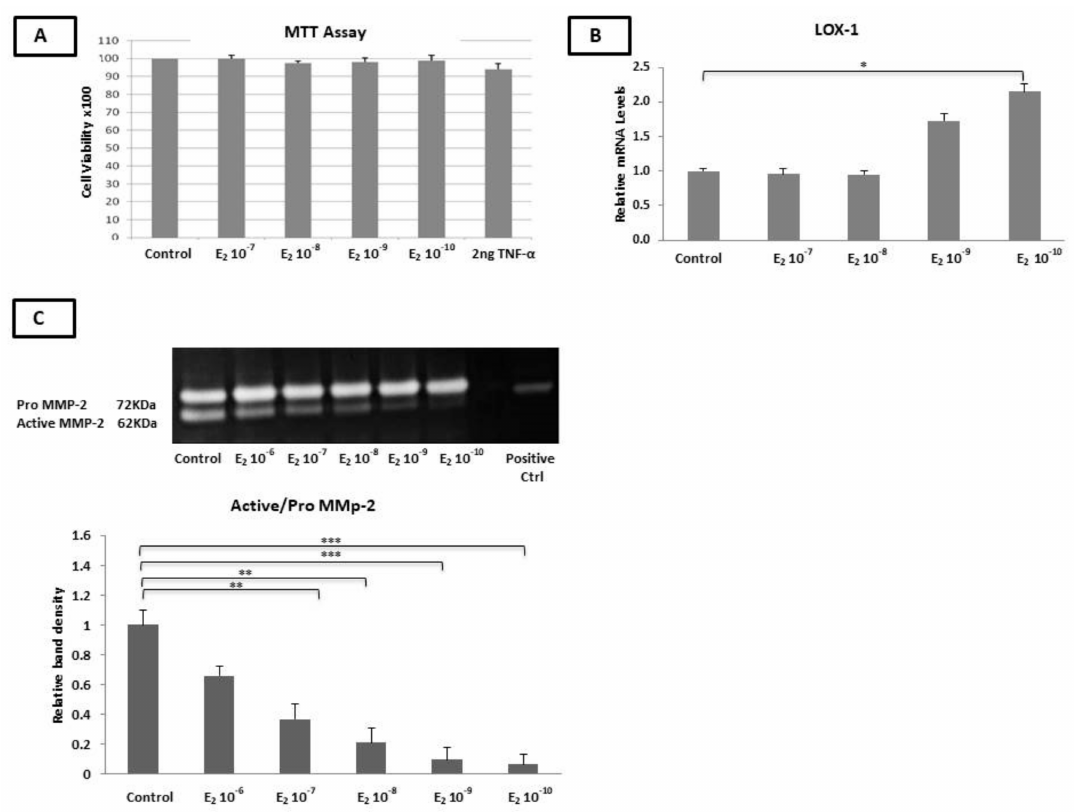
Figure 1. Effect of treatment with 10 − 10 − 10 − 7 M E 2 on cell survival, atherosclerotic gene expression, and MMP-2 gelatinase activity. ( A ) MTT assay. Incubation of HAECs with 10 − 10 –10 − 7 M E 2 or 2 ng/mL TNF- α for 24 h had no significant effect on cell viability. ( B ) LOX-1 mRNA levels were significantly increased in the presence of 10 − 10 M E 2 over 24 h. ( C ) The ratio of active MMP-2/pro- MMP-2 was significantly reduced after 24 h of incubation with various concentrations of E 2 . The graphical data are represented as mean ± SD of at least three independent experiments (*** p < 0.001, ** p < 0.01, * p <